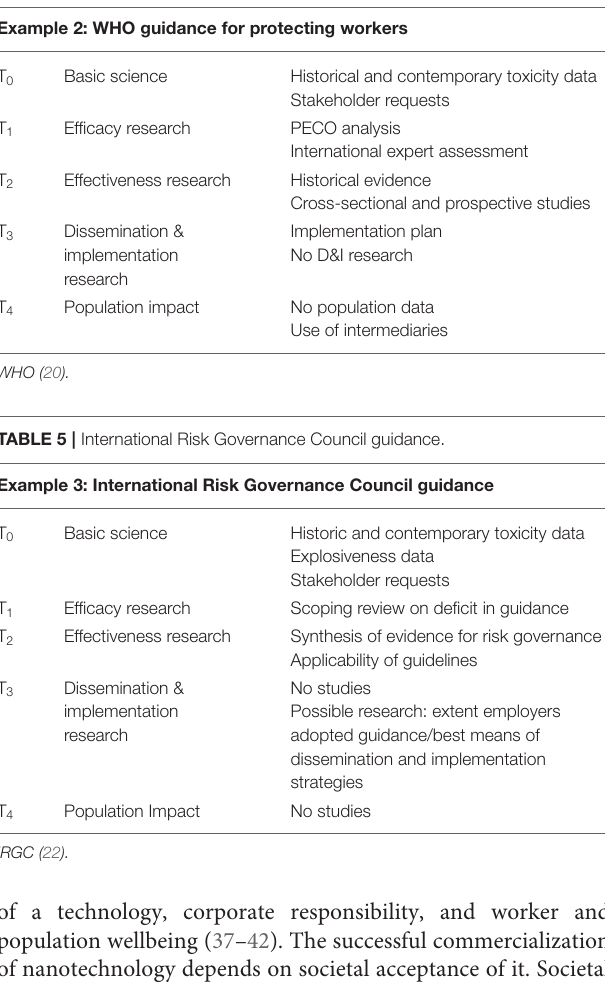
TABLE 4 | WHO Guidance for protecting workers.